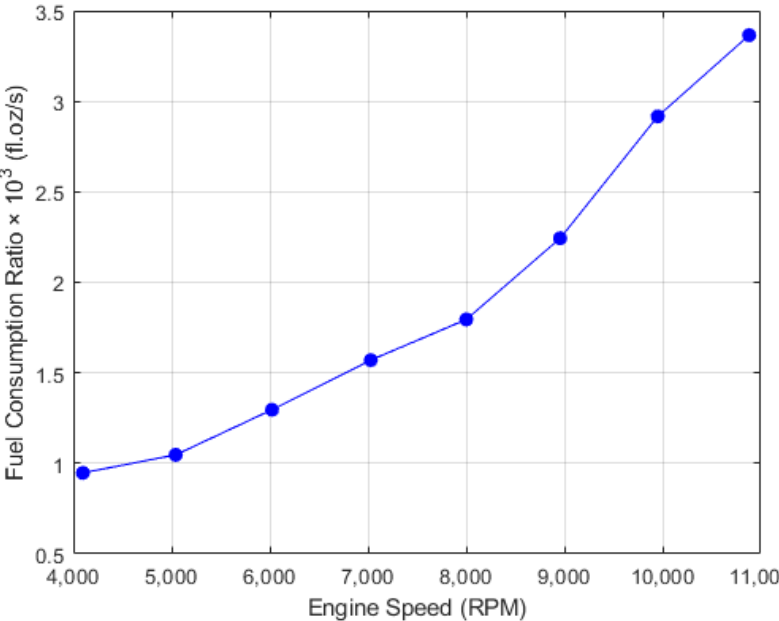
Figure 13. Fuel consumption rate of a single engine at various